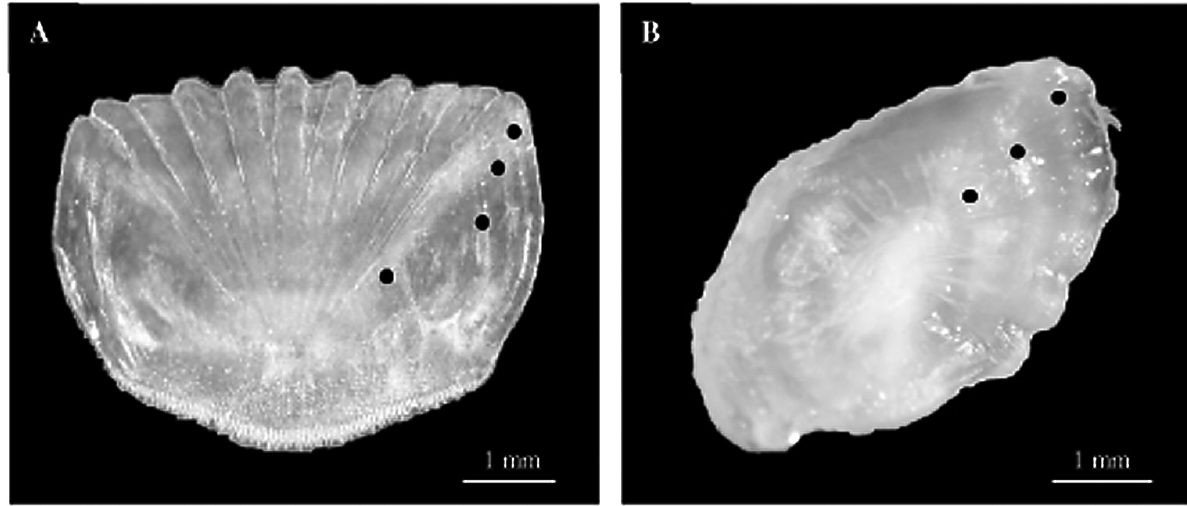
Fig. 1. – Examples of scale (A) and sagittal otolith (B) of Spondyliosoma cantharus from the Gulf of Tunis. A, individual of 4 years of age (TL=17.1 cm); B, individual of 3 years of age (TL=16.3